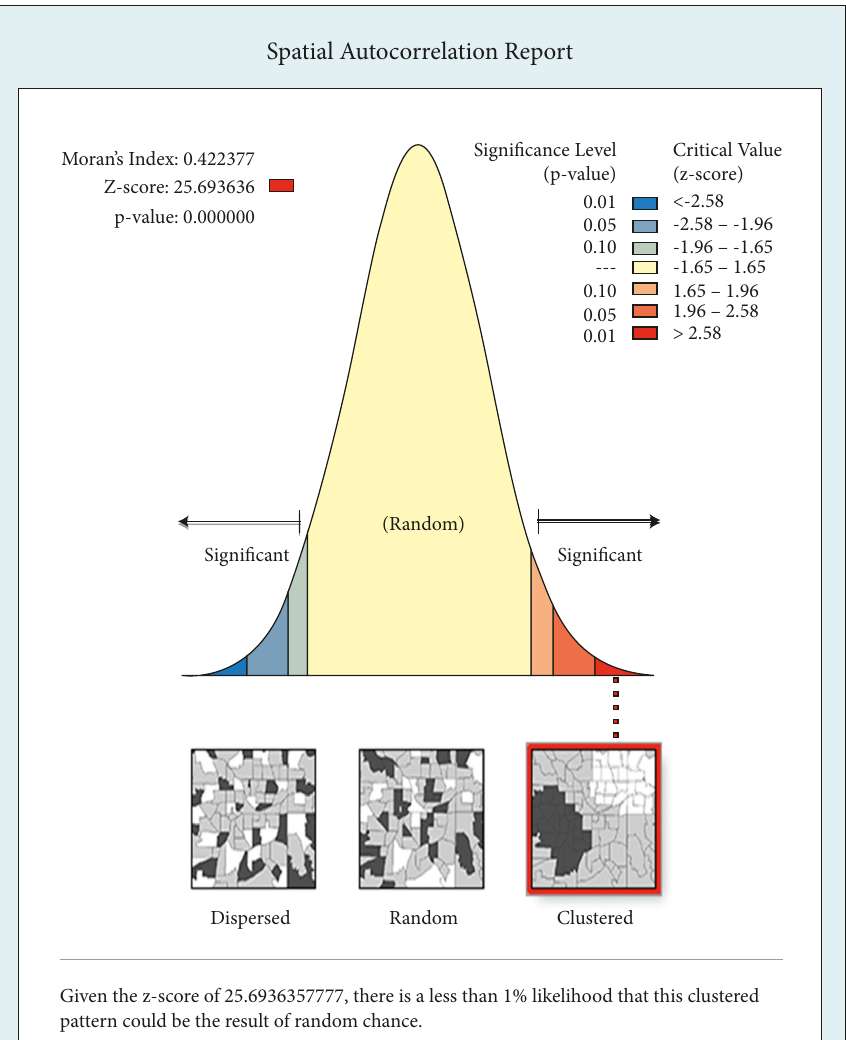
Figure 2: Spatial autocorrelation for distribution of institutional delivery in Ethiopia, 2016 (source: shape file from CSA, 2013, done using ArcGIS version